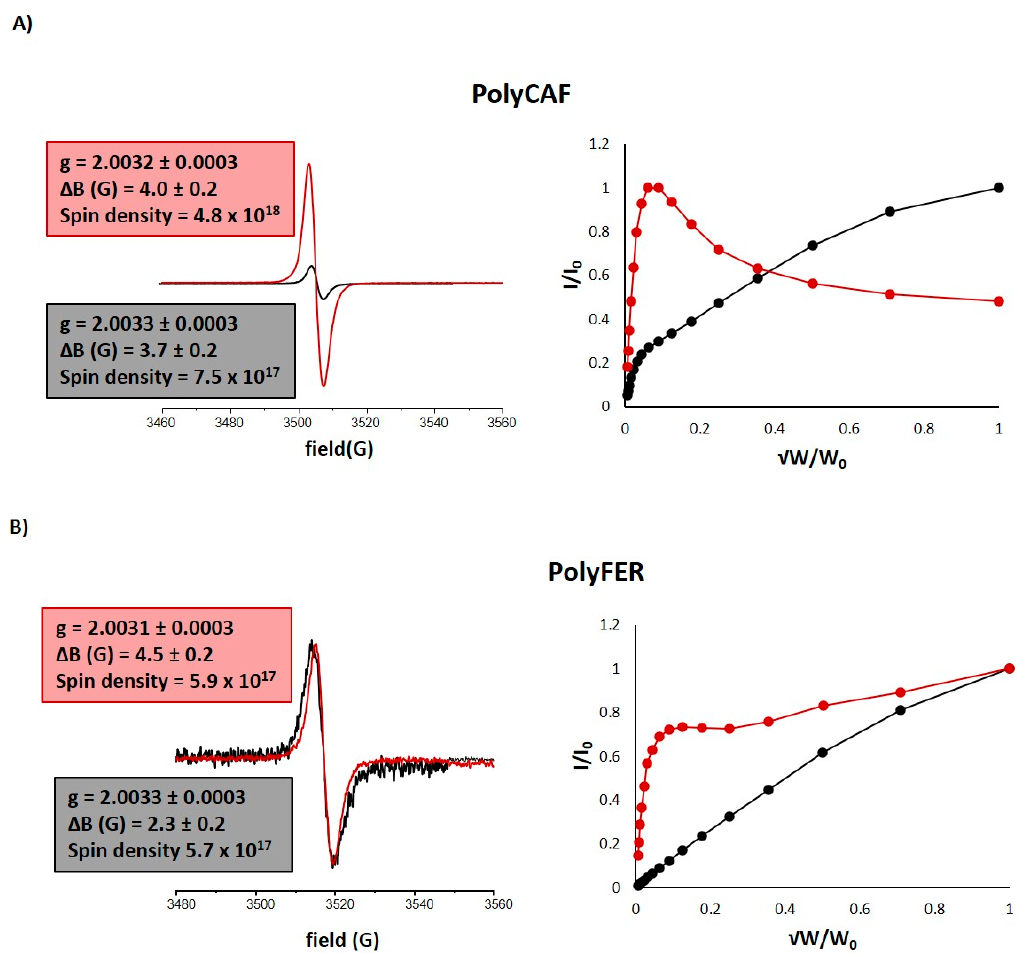
Figure 6. Solid state electron paramagnetic resonance (EPR) spectra and power saturation profiles of ( A ) PolyCAF and ( B ) PolyFER before (black traces) and after (red traces) hydrolytic treatment. Other valuable structural information was obtained by solid state 13 C NMR run in the CP-MAS